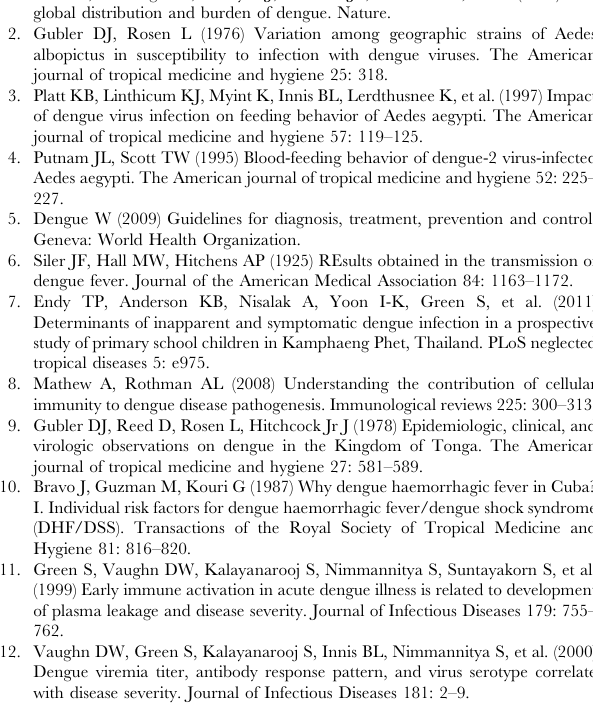
to Figure S5 for a legend explaining Pathway molecule symbols. For additional information, visit IPA legend help page at http:// (TIF) Figure S5 Pathway molecule symbols legend from Ingenuity Pathway Analysis. The color scheme used to indicate up- and down-regulation is different from that used by IPA and the intensity varies according to fold change. For additional information, visit IPA legend help page at http:// Table S1 53 of the selected canonical pathways studied, with genes up- and down-regulated in the subclinical/ asymptomatic dengue are indicated. Linear fold change (asymptomatic versus symptomatic) values are shown in bracket for those genes discussed in the manuscript. The pathways have been grouped according to the broad categories of reported dengue host defence mechanisms. The gene symbols are based on HUGO Gene Nomenclature Committee (HGNC)